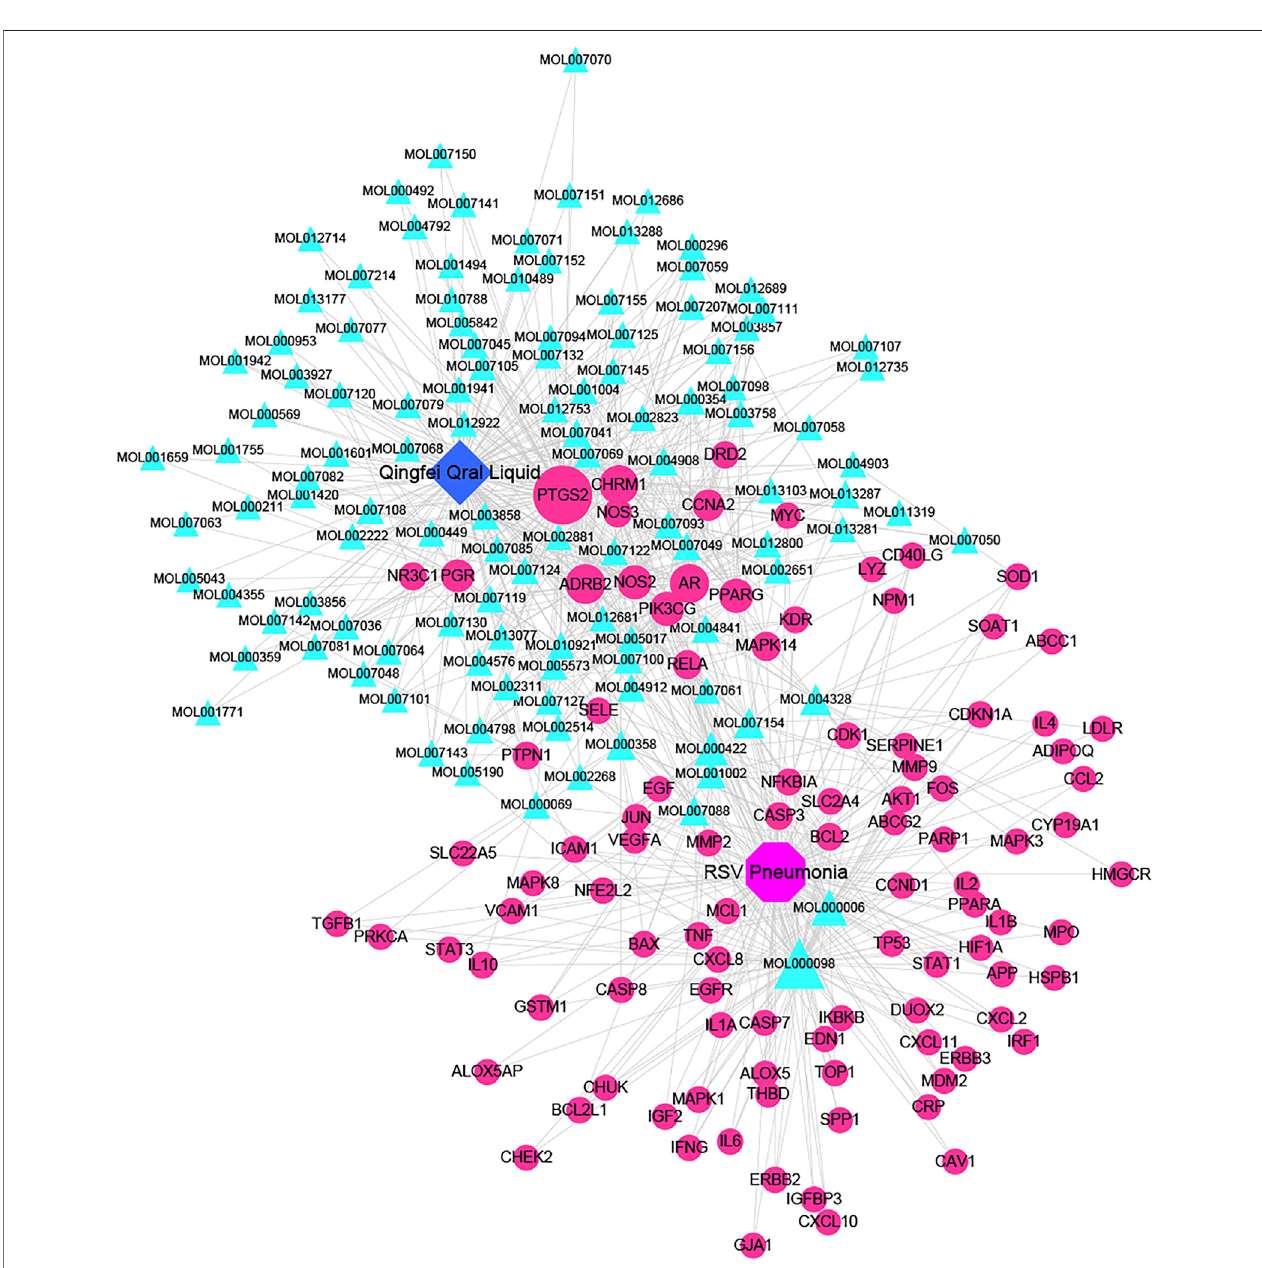
FIGURE 3 | Active compound-core target network of QF in the treatment of RSV-induced lung in fl ammation. Blue triangle nodes represent the molecular identi fi cation (MOL ID) number of active components in QF, and red circle nodes represent the core targets. Edges represent interactions between compounds and targets. The size of each node is positively correlated with the degree value. Abbreviations: QF, Qingfei oral liquid; RSV, respiratory syncytial virus.